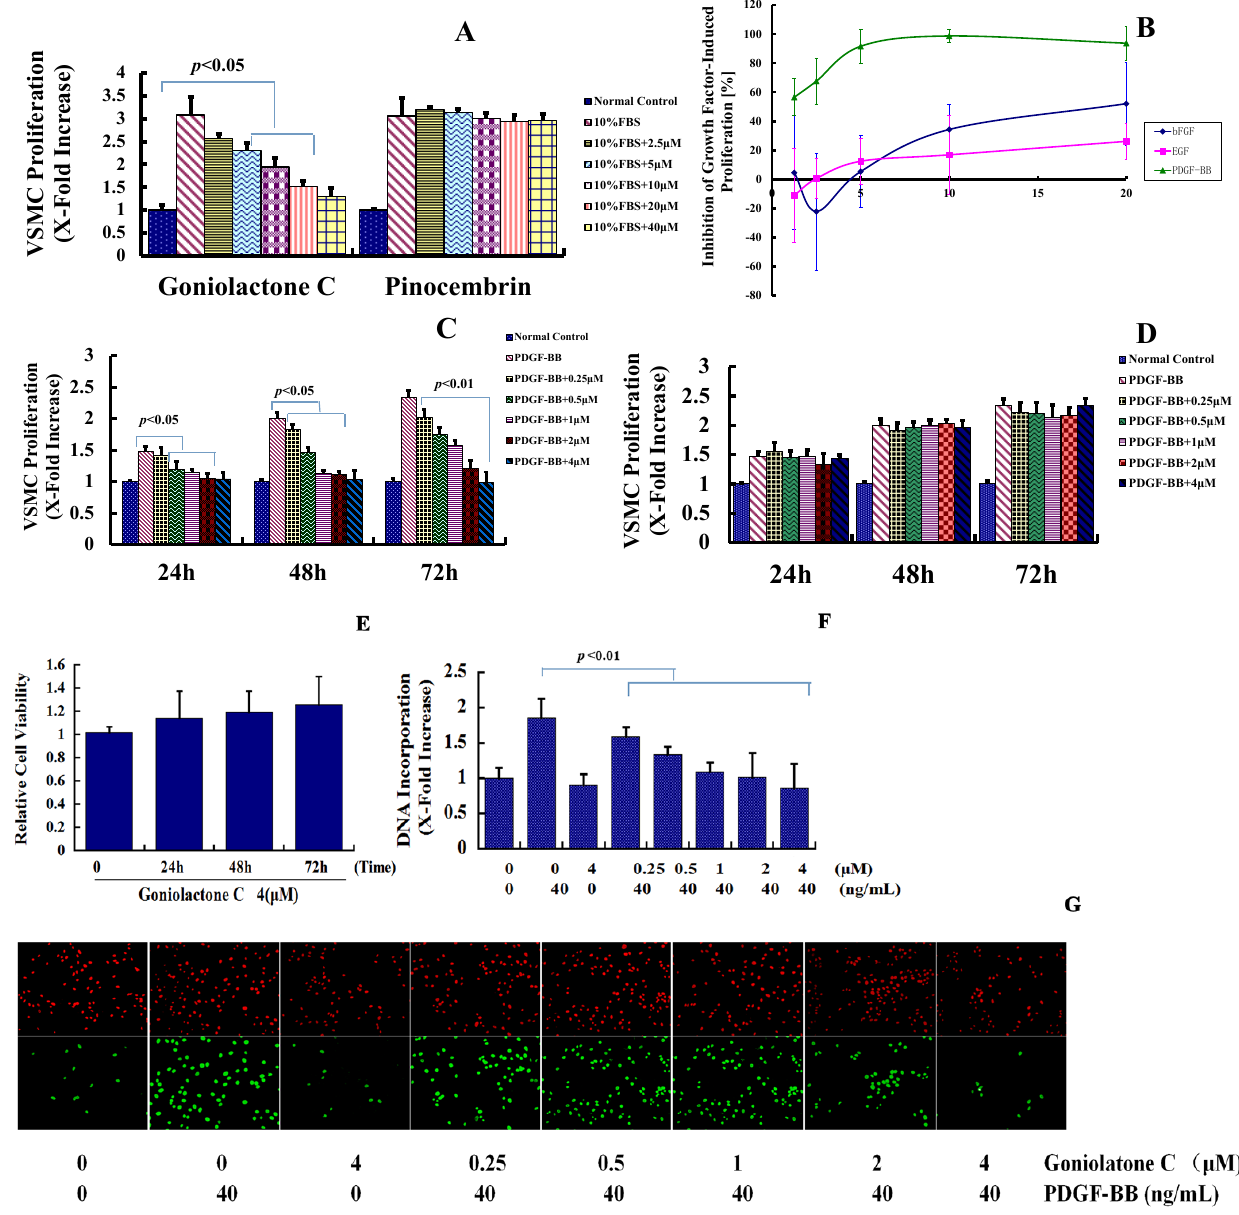
Figure 2. Goniolactone C specifically reduces PDGF-BB-induced VSMC proliferation. ( A ) Goniolactone C but not Pinocembrin inhibits serum-induced VSMC proliferation. Proliferation was expressed as an x-fold increase compared to normal control VSMCs that were incubated in the absence of FBS. ( B ) Goniolactone C attenuates PDGF-induced VSMC proliferation. ( C , D ) Goniolactone C (C) but not Pinocembrin (D) inhibits PDGF-BB-induced VSMC proliferation in both a time- and concentration-dependent manner. ( E ) Goniolactone C is not cytotoxic in VSMCs. Confluent VSMCs were treated with 4 μM goniolactone C for 24, 48 and 72 h. ( F ) Goniolactone C inhibits PDGF-BB-induced VSMC DNA synthesis by usding BrdU incoporation assay. ( G ) The green fluorescence (bottom) represents BrdU positive cells, DAPI was employed to detect the nuclei (upper). The data are expressed as the means ± SEM and are representative of three independent